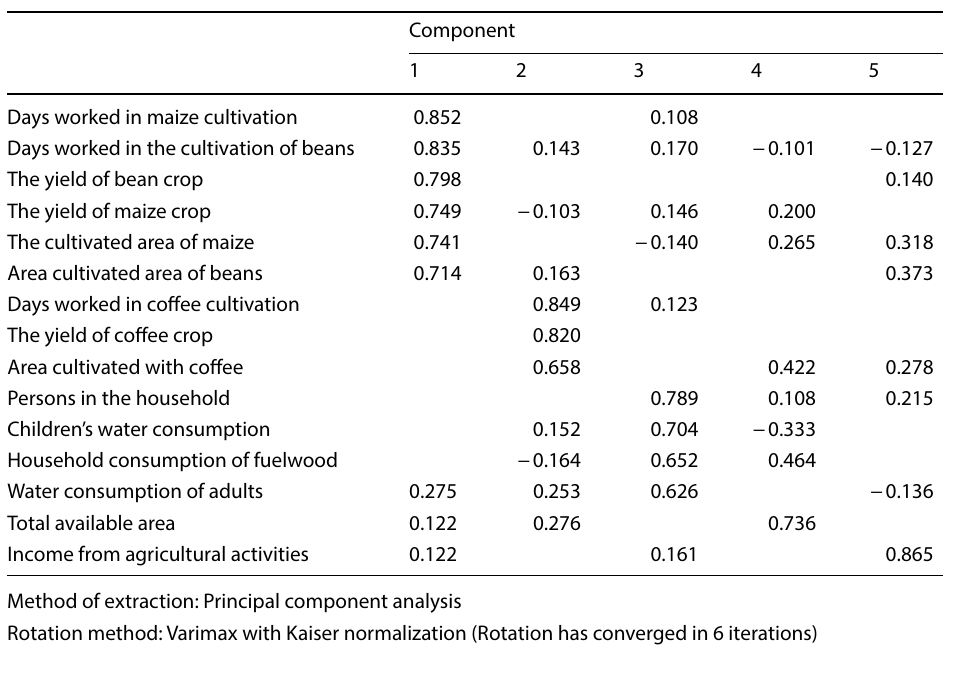
Fig. 2 A component graph in rotated space in three dimen-